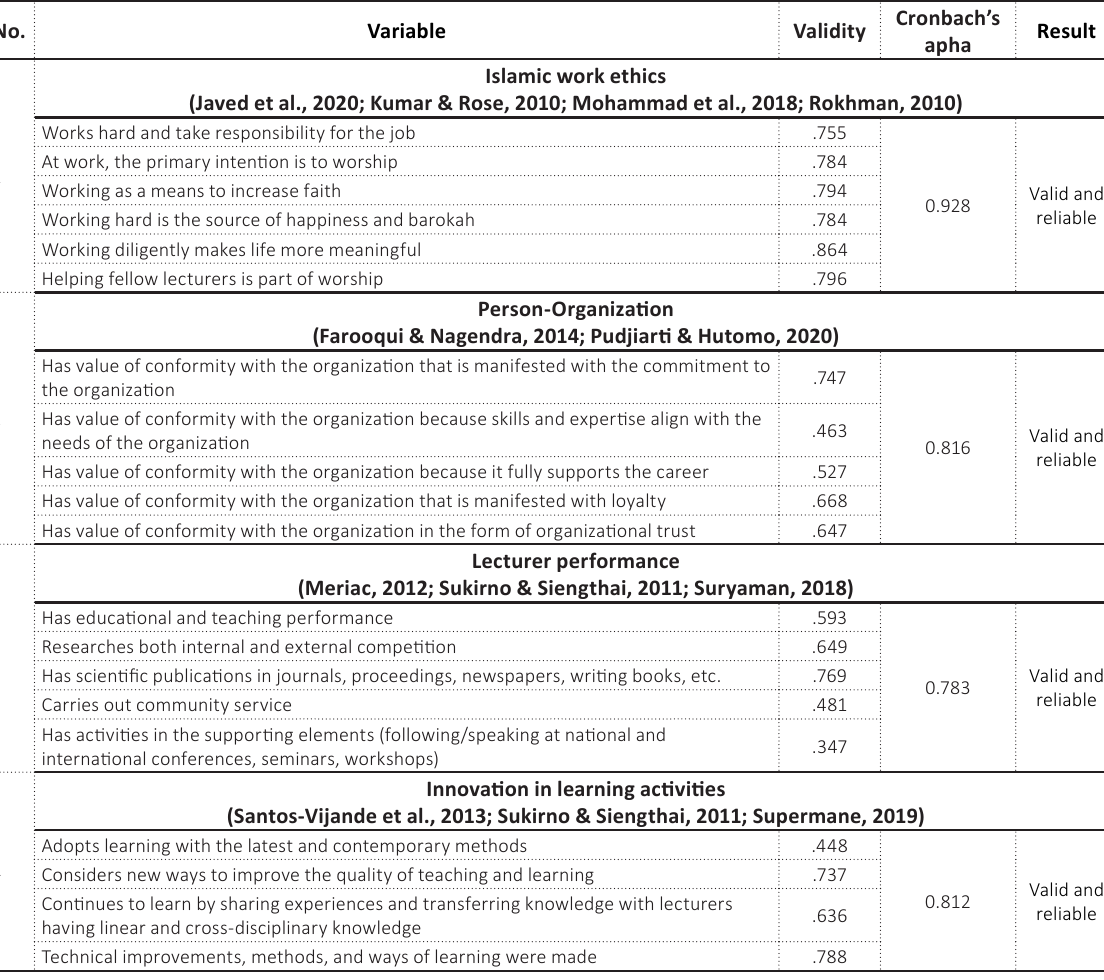
Table 2. Validity and reliability